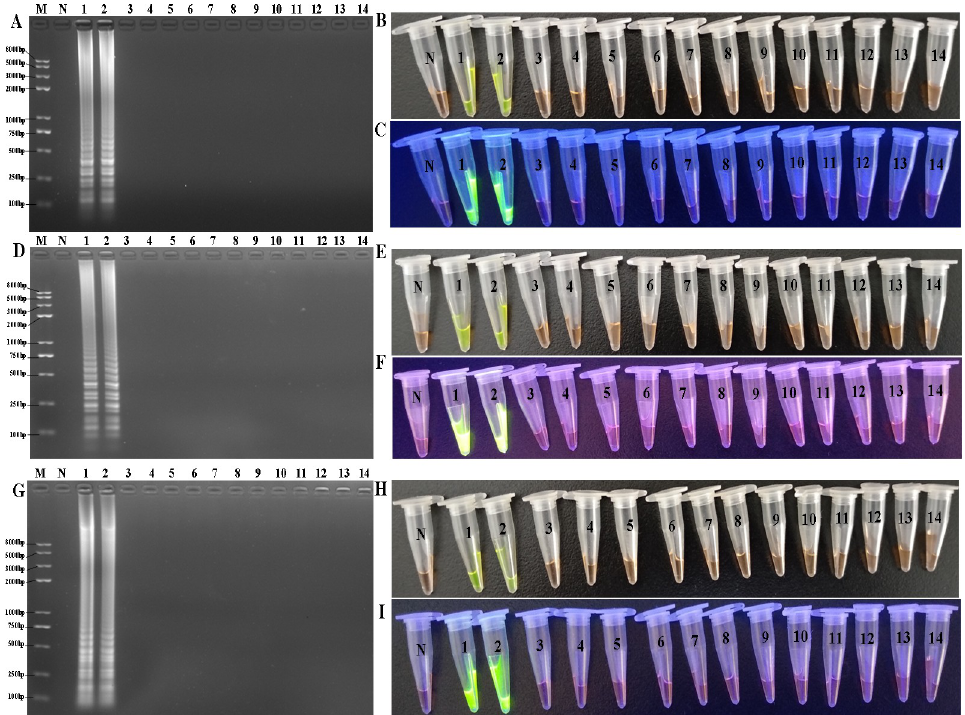
Fig 6. Specificities of LAMP, CPA and IMSA. A, D and G, Agarose gel electrophoresis analysis of LAMP, CPA and IMSA products; B, E and H, Direct visualization under natural light after staining with SYBR Green I for LAMP, CPA and IMSA reactions; C, F and I, Visualization under UV light after staining with SYBR Green I for LAMP, CPA and IMSA reactions; 1–2, OS-1 and OS-6, respectively. 4–14, C83920, C44498, O157:H7, C83903, ATCC7966, ATCC13076, ATCC13311, ATCC25923, ATCC29213, ATCC23715, ATCC27519 and ATCC13124, respectively. M, Trans 2K plus II DNA marker; N, negative control.